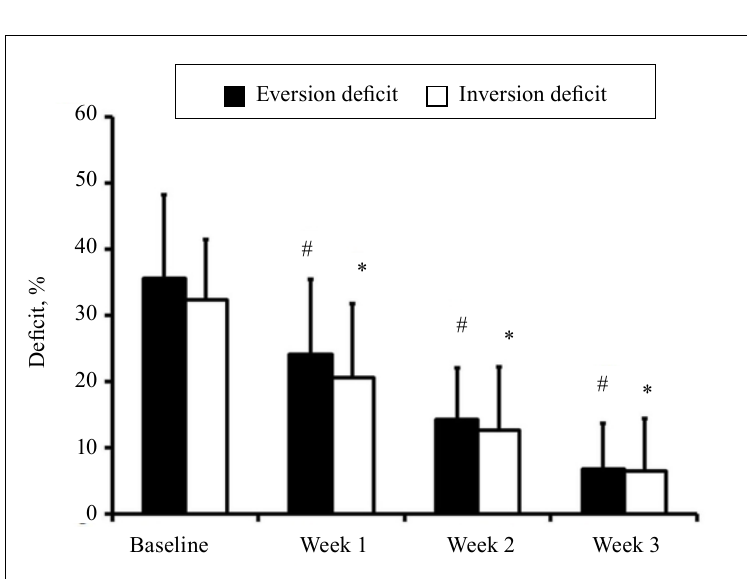
Figure 2. Changes of eversion and inversion deficit during rehabilitation